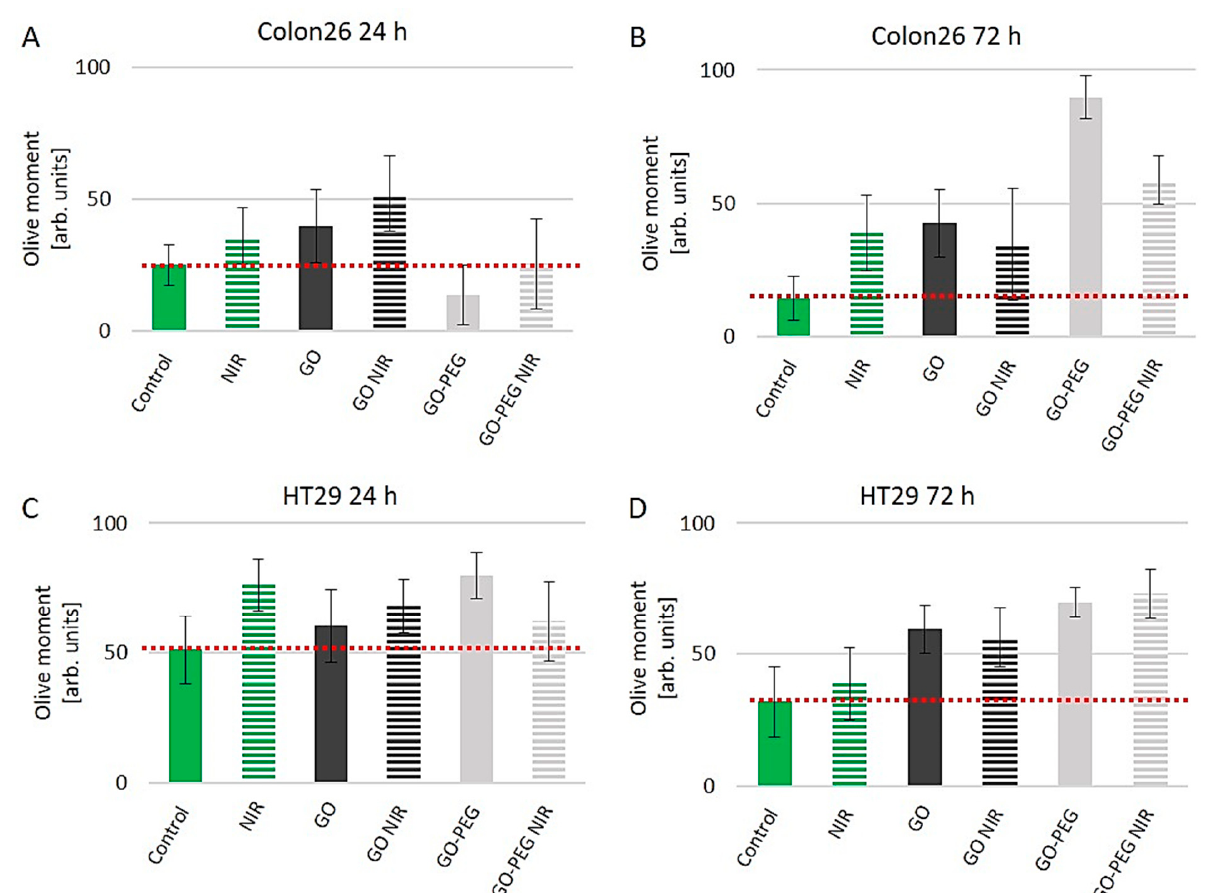
Figure 6. Investigation of the genotoxic potential of GO and GO–PEG with and without NIR irradiation on Colon26 and HT29 cells by the method of SCGE. ( A ) The parameter Olive Moment calculated for Colon26 cells cultivated for 24 h in the presence of the NPs with and without NIR irradiation. ( B ) The parameter Olive Moment calculated for Colon26 cells cultivated for 72 h in the presence of the NPs with and without NIR irradiation. ( C ) The parameter Olive Moment calculated for HT29 cells cultivated for 24 h in the presence of the NPs with and without NIR irradiation. ( D ) The parameter Olive Moment calculated for HT29 cells cultivated for 72 h in the presence of the NPs with and without NIR irradiation. The dotted red lines denote the threshold, above which we detect genotoxicity. Values of the Olive moment are the MEAN ± . STDV from three repetitions of the experiment.